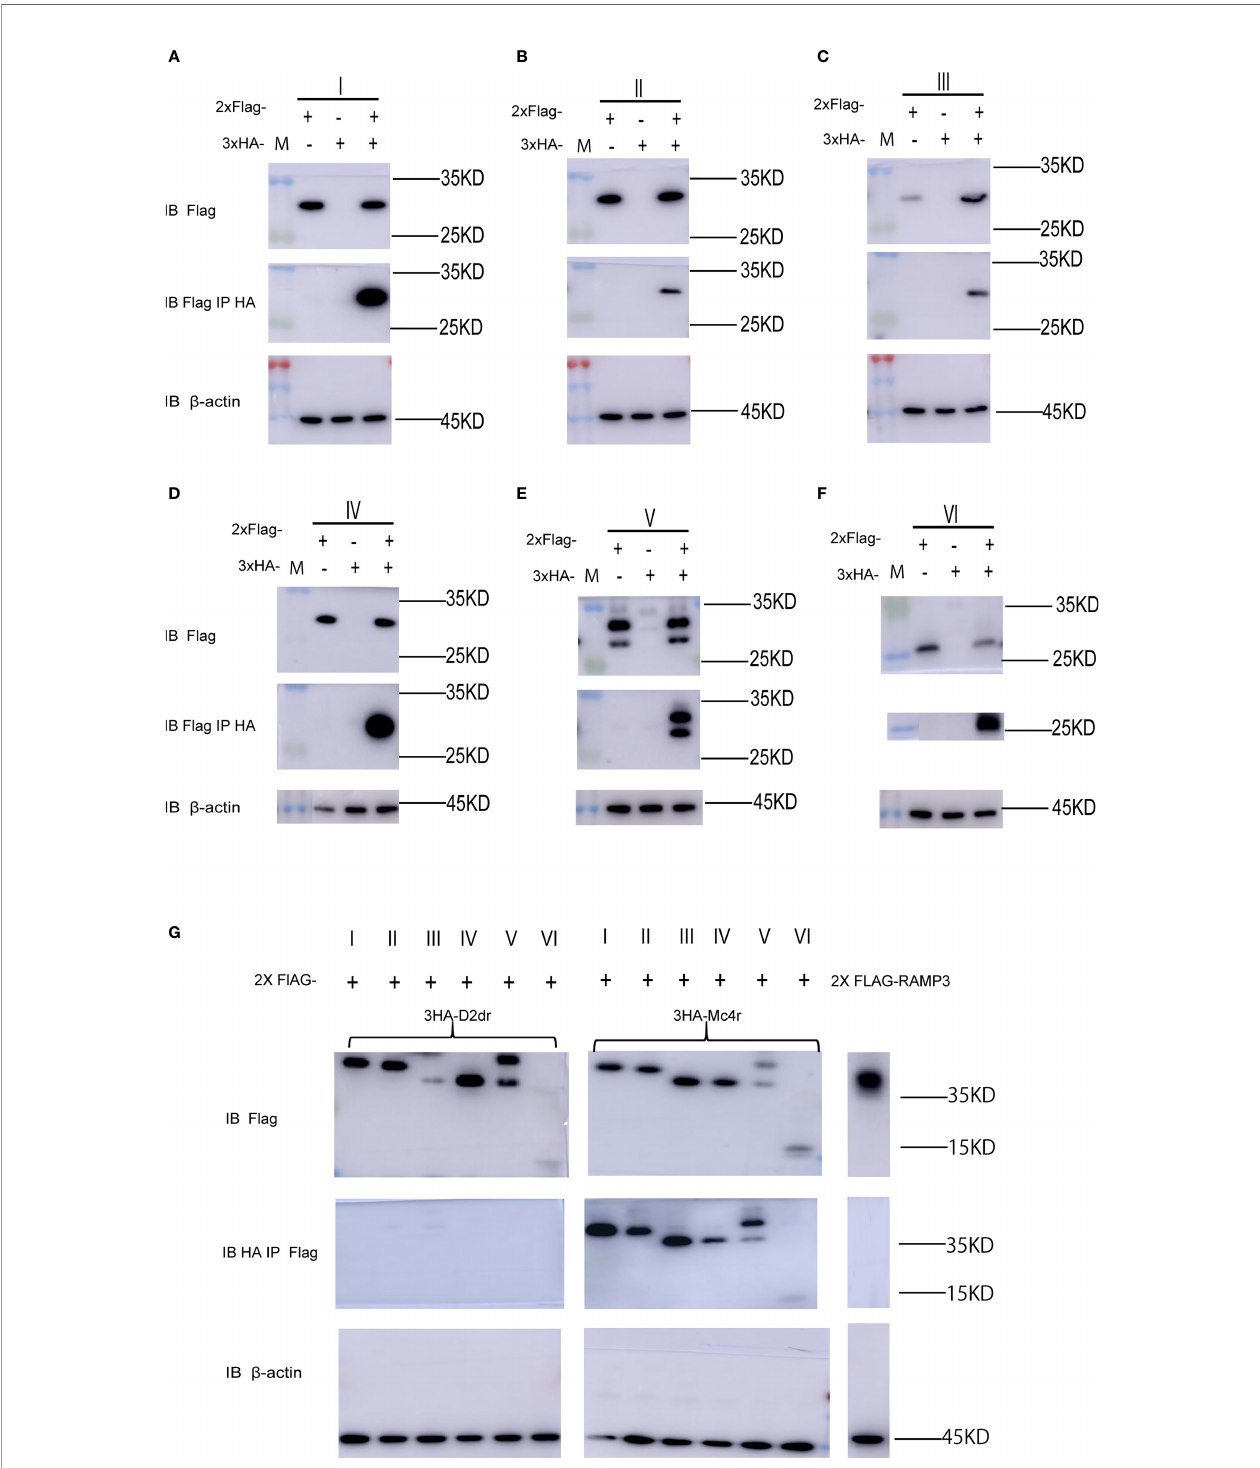
FIGURE 2 | Melanocortin receptor accessory protein 2 (MRAP2) variants form proper homodimers and interact with melanocortin-4 receptor (MC4R). (A – F) Co- immunoprecipitation (IP) of the 2FLAG-tagged and 3HA-tagged MRAP2 variants I, II, III, IV, V, and VI. The order of transfection in each group is from left to right : 2FLAG-tagged variant transfected only, 3HA-tagged variant transfected only, and 2FLAG-tagged and 3HA-tagged variants co-transfected. (G) Immunoprecipitation and Western blot detection of 3HA-D2dr, 3HA-MC4R, and 2Flag-MRAP2 variants or RAMP3. MRAP2 variants and RAMP3 were detected using mouse anti-Flag antibody. IB , immunoblotting, beads only, no antibody was used for the